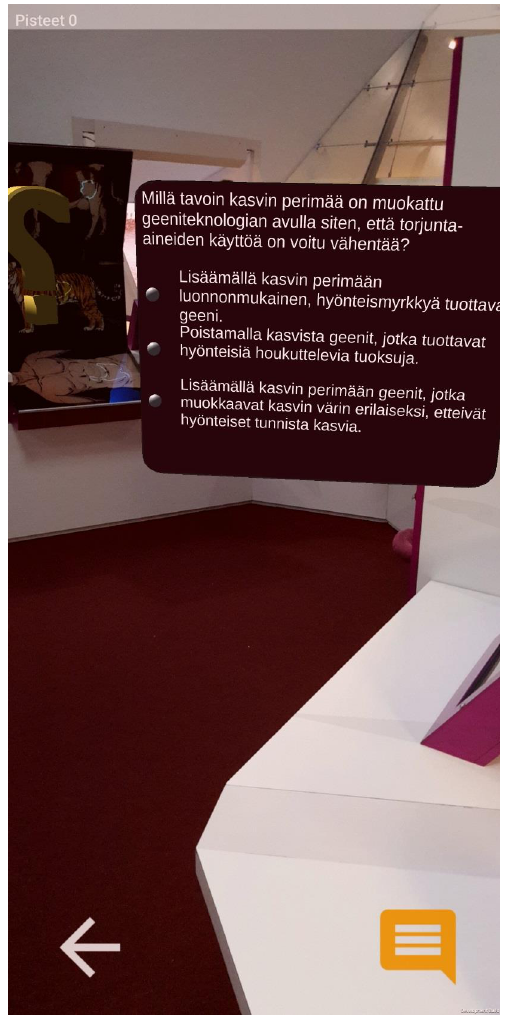
Figure A1. A Screenshot of the AR App Game Mode.